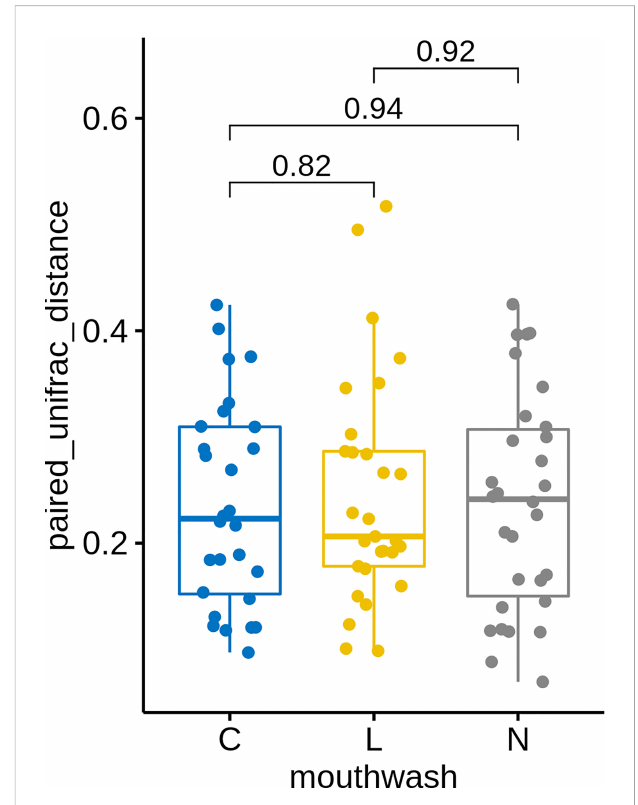
FIGURE 6 UniFrac distances between microbiota before and after gargling of the same individuals in three mouthwash groups. Differences between groups are tested by Wilcoxon rank